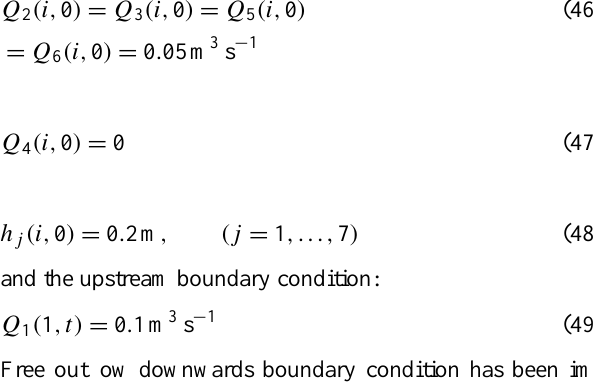
ulating highly transient mixed flows. Journal of Computational and Applied Mathematics 235, 2030-2040.